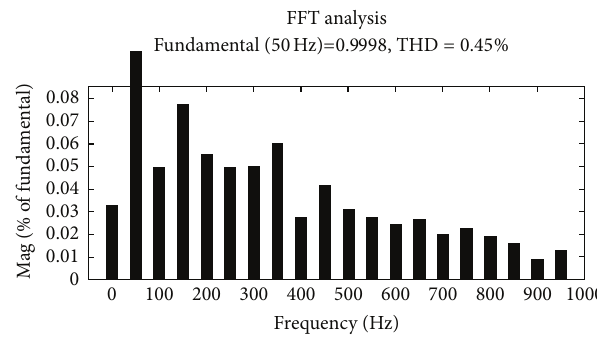
Figure 11: Source voltage THD graph.